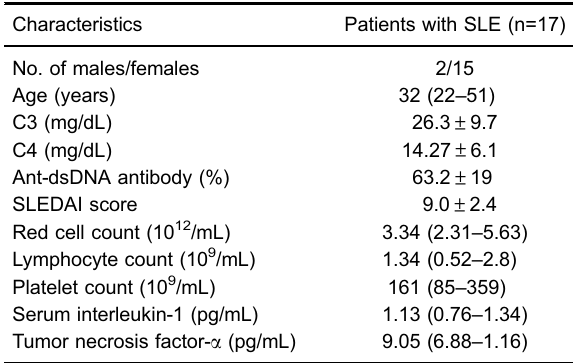
Table 1. Clinical and laboratory characteristics of patients with active systemic lupus erythematosus (SLE). Characteristics